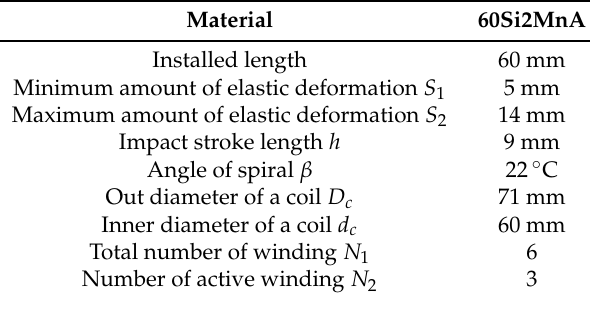
Table 2. Parameters of pressure spring.